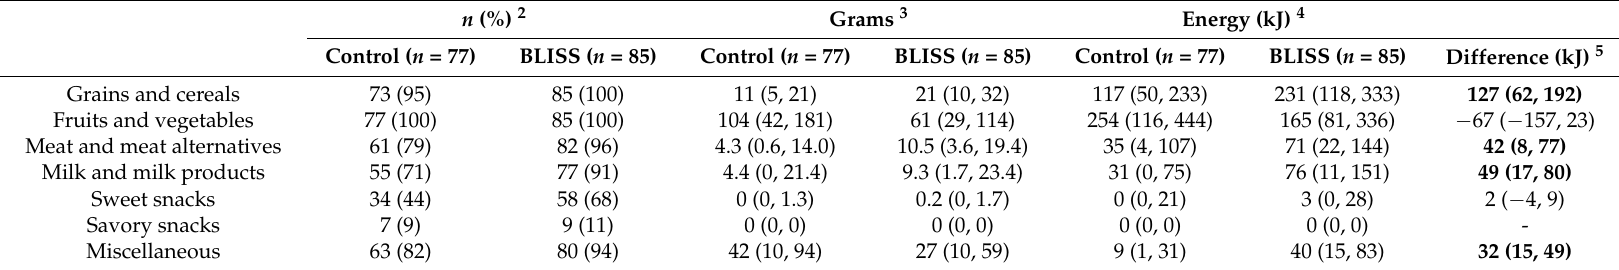
Table 6. Sources of energy (kJ) at 7 months of age from complementary foods alone, by food group. 1.